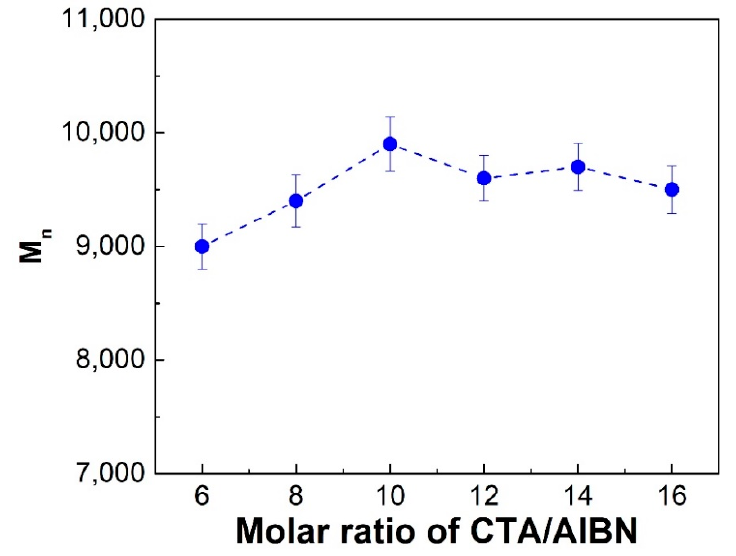
Figure 9. The effect of molar ratio of CTA and initiator on molecular weight of PAM. The plot of M n vs. polymerization time. Polymerization conditions: [M] 0 , 12%; range of [CTA] 0 /[AIBN] 0 , 6 to 12; temperature range, 60 °C to 85 °C.